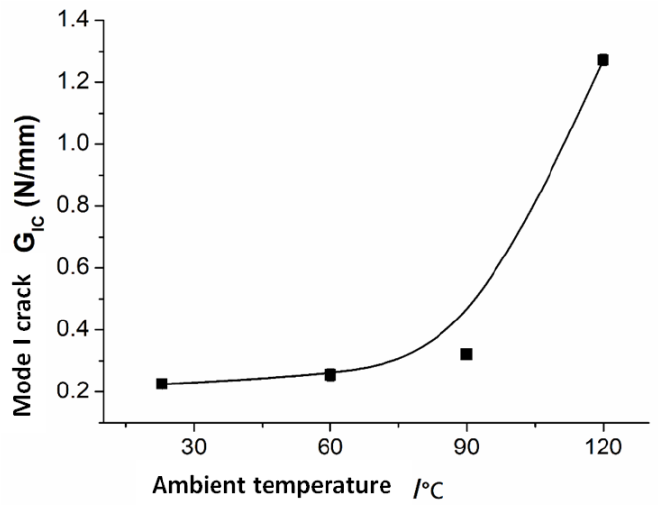
Figure 9. Mode I crack fracture toughness vs. ambient temperature.